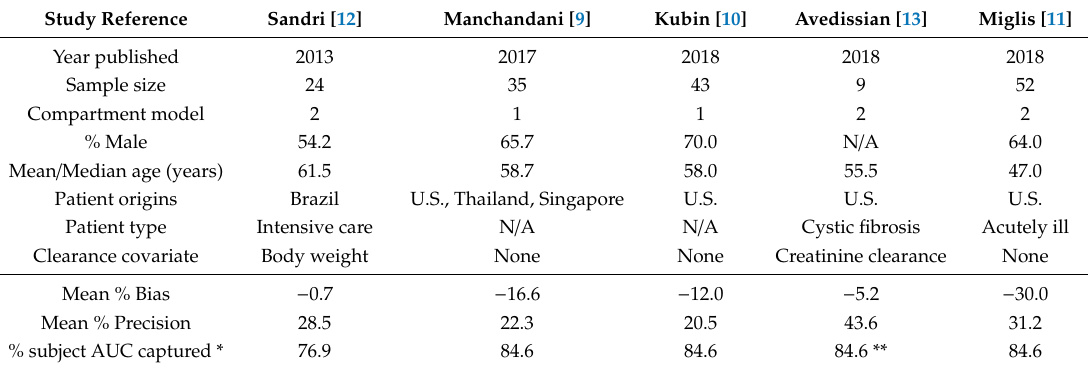
Table 1. Characteristics and summary of population pharmacokinetic models of polymyxin